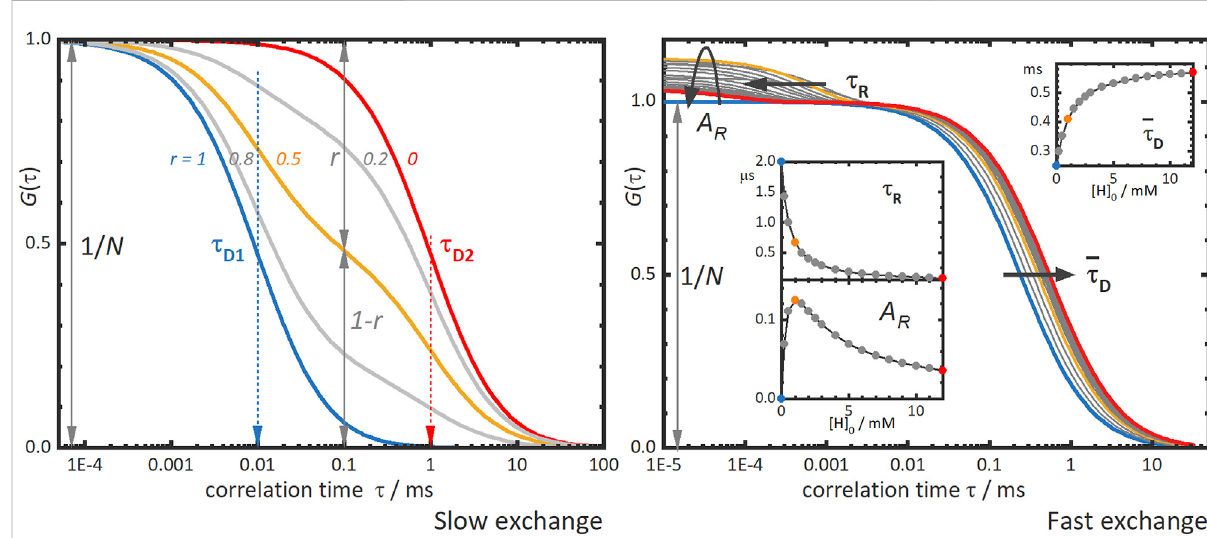
FIGURE 2 Simulated fl uorescence correlation curves obtained in theslow and fast exchange regimes. Left panel: “ Slow exchange ”— the correlation curve showstwodiffusionterms,oneforeachdiffusingspecies,afastonewith τ D1 ,andanothersloweronewith τ D2 .Inhost-guestsystemsasthatdepicted inFigure1,these speciescorrespondto theguestwith or τ D,G ,andthecomplexwith τ D,H:G ,respectively. Thedifferentcorrelationcurves inthepanel correspondto differentcontributionsofthetwospeciesto thecurveasgivenbytheparameter r .The bluecurvewith r =1andtheredonewith r = 0 would be obtained for solutions of only fast or slow species, respectively. The grey and orange intermediate curves correspond to mixtures of fast and slow species with r -values as indicated in the fi gure. Right panel: “ Fast exchange ”— the correlation curve shifts towards longer correlation times as the concentration of host is increased. The blue curve corresponds to that of free guest alone and the grey, orange, and red curves to increasing concentrations of host. The inserts show the dependence on the total host concentration, [H] 0 , of the mean diffusion time, (cid:1) τ D , the relaxationtime, τ R ,andtheamplitude, A R ,ofthereactionterm.Inbothregimes, theamplitudeofthediffusiontermisgivenbytheinverseofthetotal number of diffusing species, N